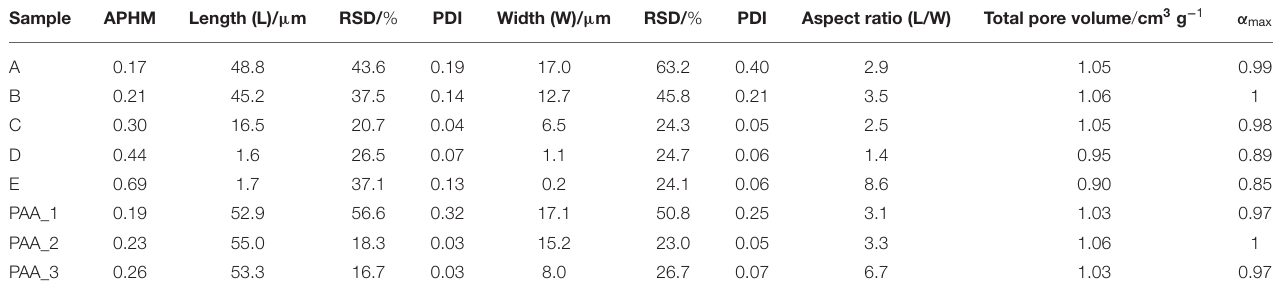
TABLE 1 | Characteristics of the investigated samples.